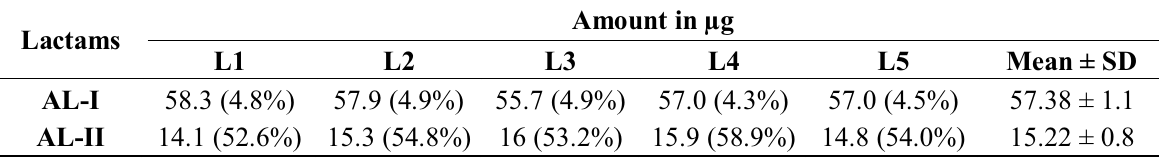
Table 3. Amount of lactams retained by one average larva (average weight of 2.01 ± 0.3 g) from sample groups L1-L5 before pupating. Values between brackets correspond to the percentage of lactam retained by one larva relative to the total amount it